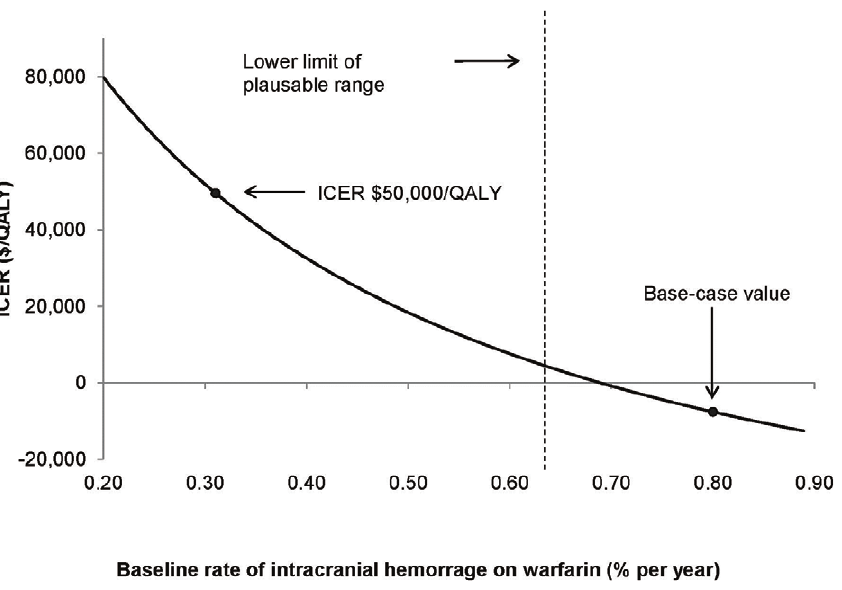
Figure 2. One-way sensitivity analysis of baseline rate of ICH on warfarin. This figure depicts the effect of varying baseline intracranial hemorrhage rates on the ICER. Vertical dotted line demarcates the lower limit of the plausible range (i.e., 0.63% per year).